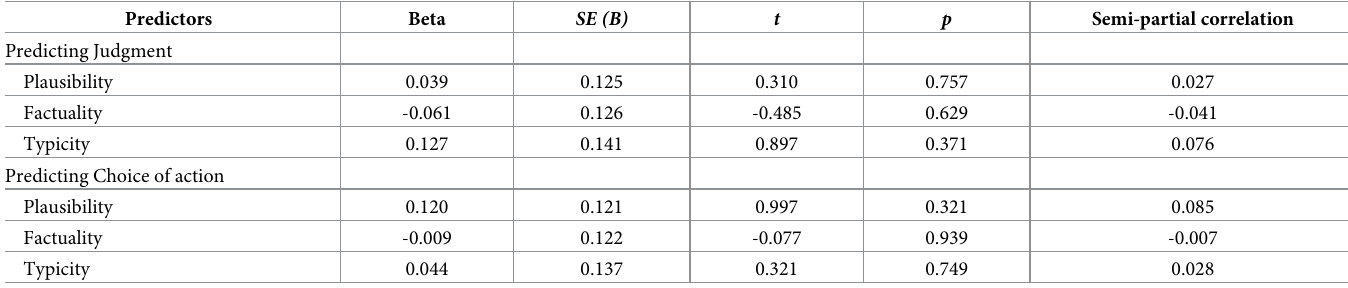
Table 3. Multiple regression analysis on judgment and choice of action with perceived plausibility, factuality and typicality of dilemma as predictors.